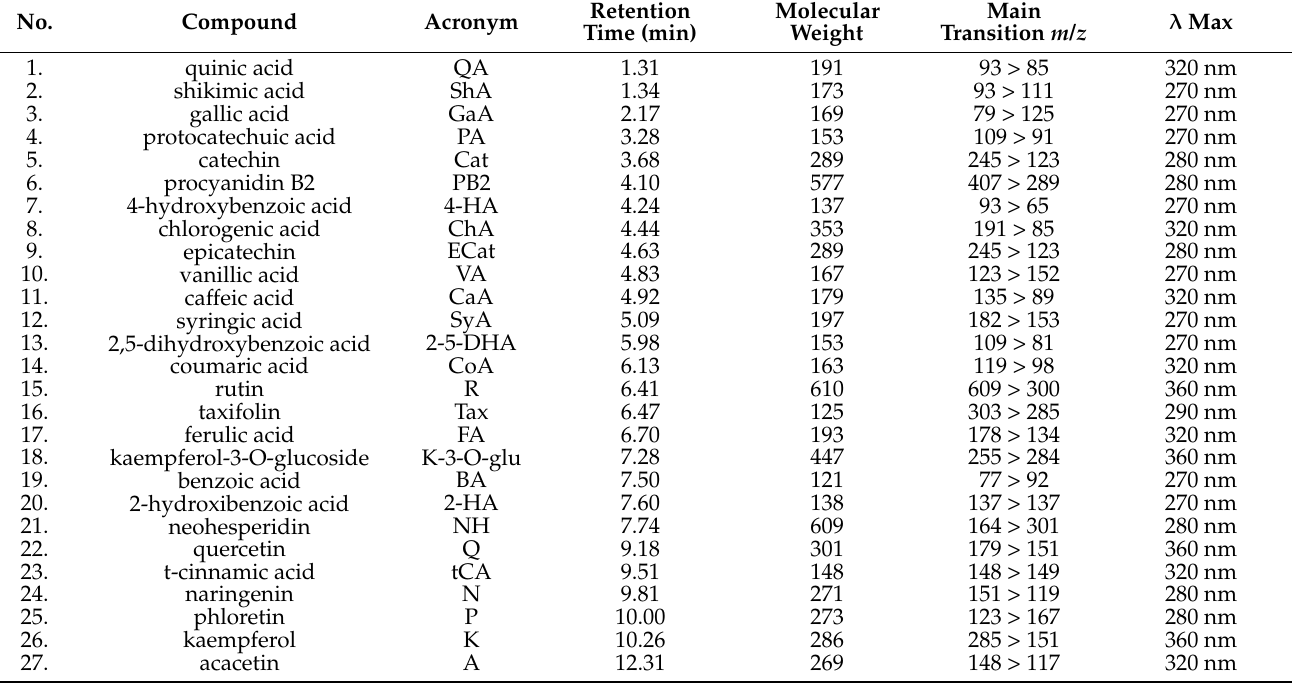
Table 1. Compounds identified in Quince fruit ( Cydonia oblonga Mill.) by